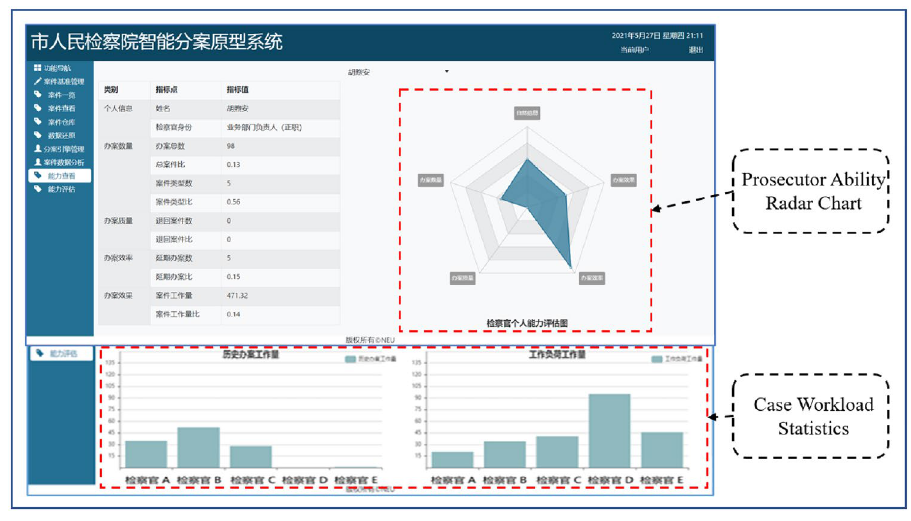
Figure 10. The application of